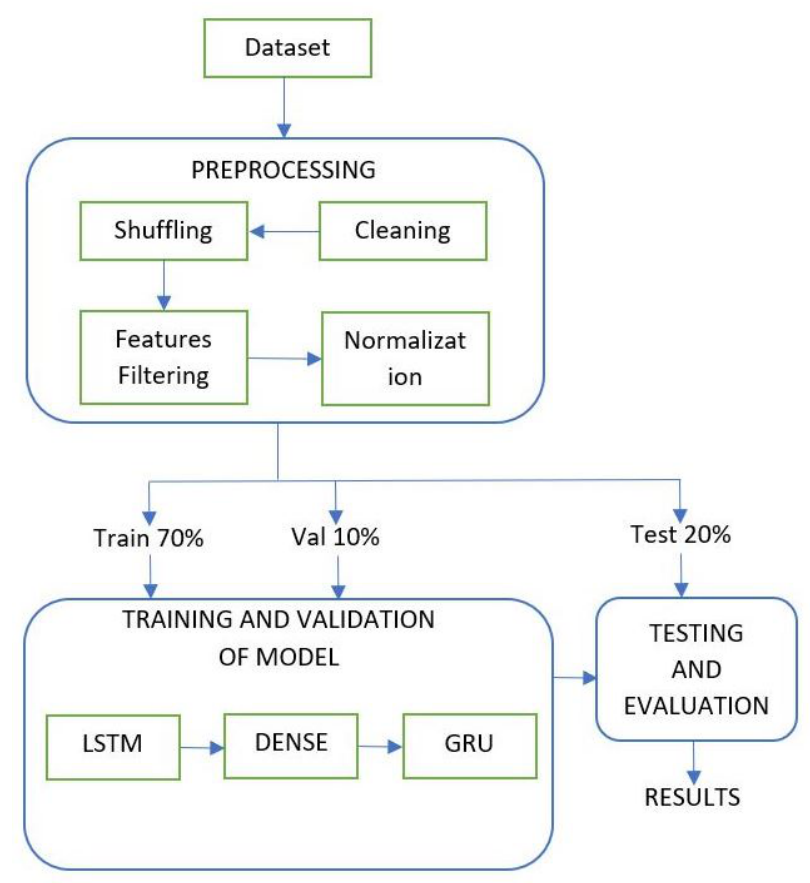
Figure 2. Block diagram of the proposed model for intrusion detection in